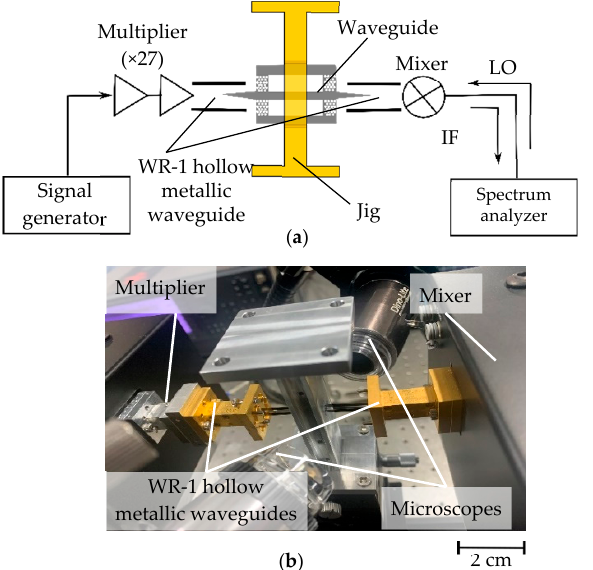
Figure 6. Experimental setup for the measurement of the transmittance: ( a ) Schematic of the setup; ( b ) Photograph of the setup.